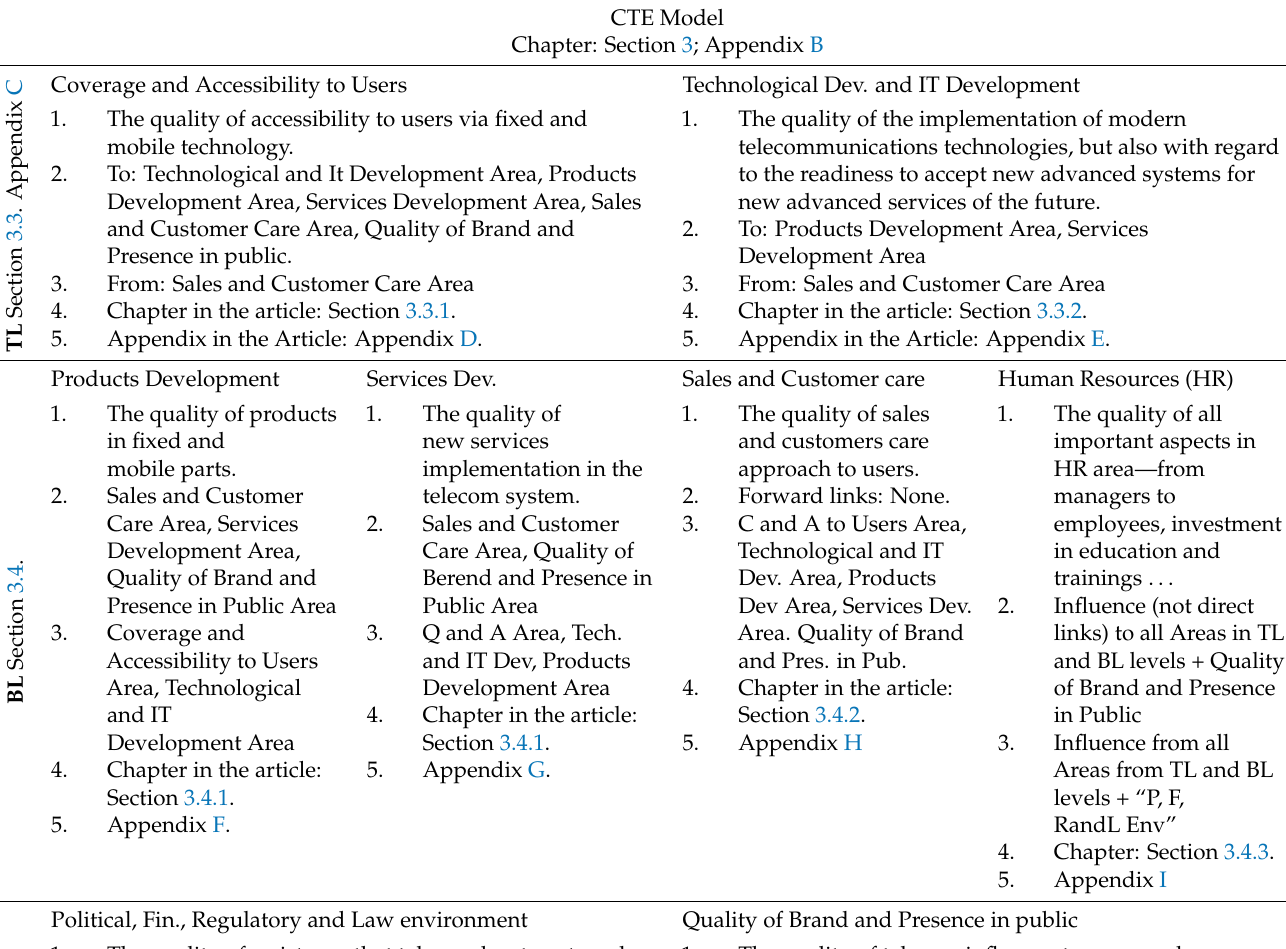
Table 2. CTE model—brief explanations and connections to the text in the